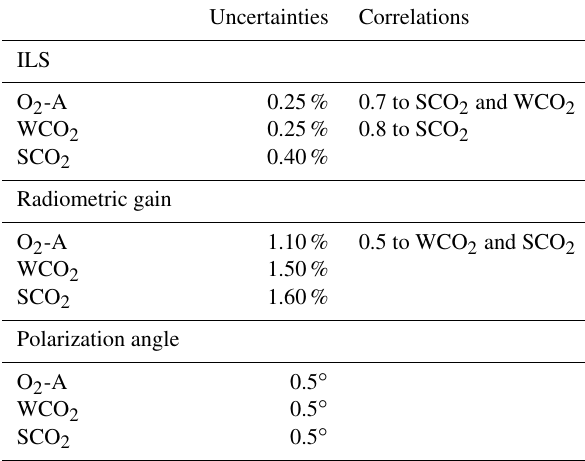
Table 2. Uncertainties in calibration parameters used in the L2 al- gorithm.